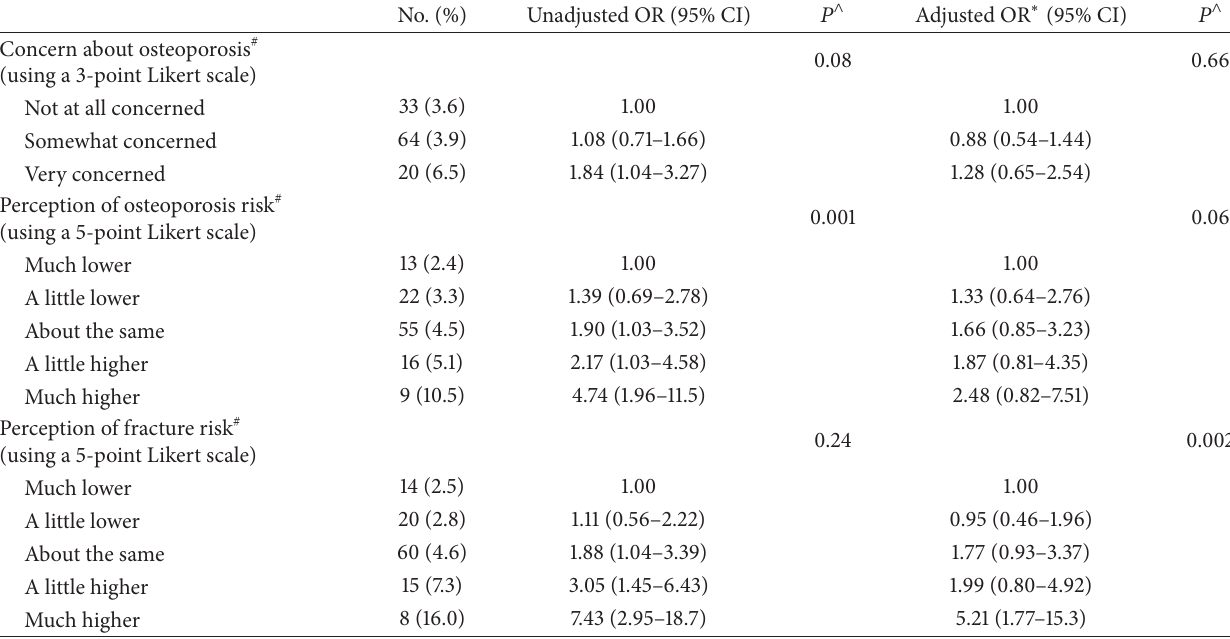
Table 5: Odds ratio (ORs) of anti-osteoporosis medication (AOM) use in the next 12 months for covariates about concern and risk perception of